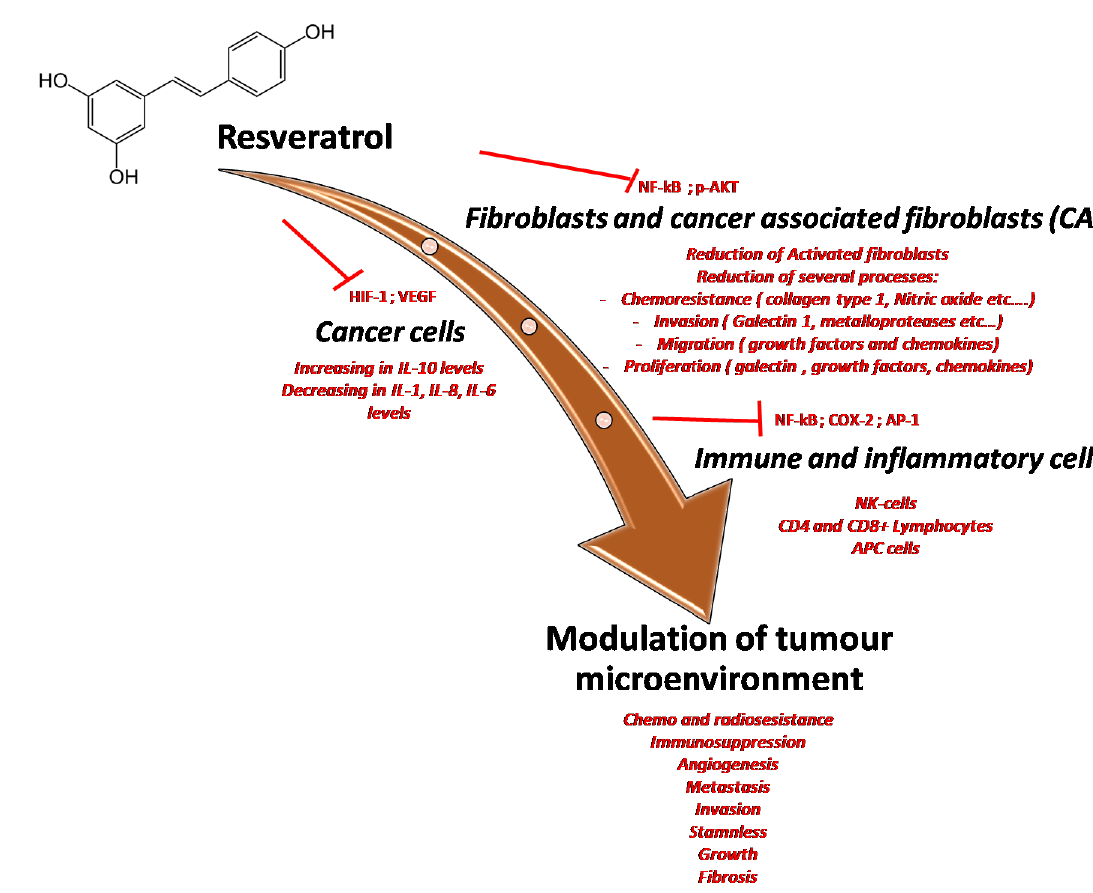
Figure 7. Multiple effects of resveratrol on the tumor microenvironment through the inhibition of many pro-inflammatory mediators and cytokines involved in cancer cell survival, in cancer-associated fibroblast activation and modulation of immune cells resident in tumor tissue.